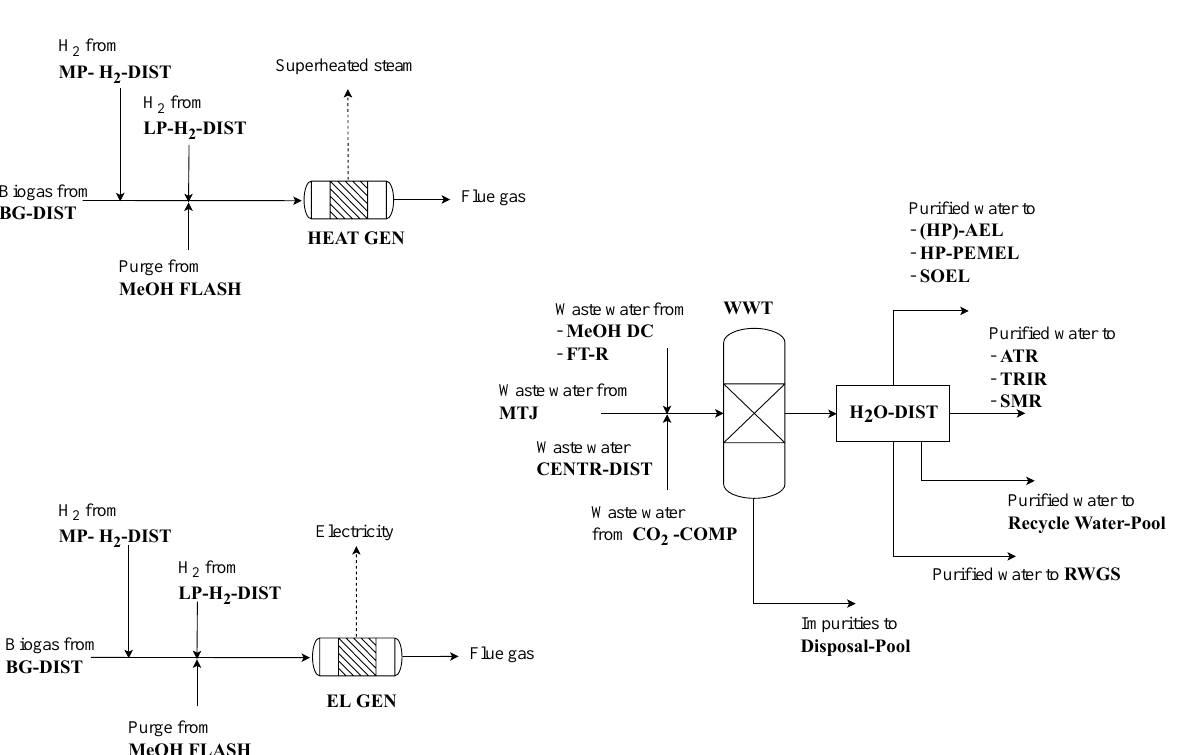
Figure 8. Wastewater and purge gas treatment process section of renewable refinery superstructure.